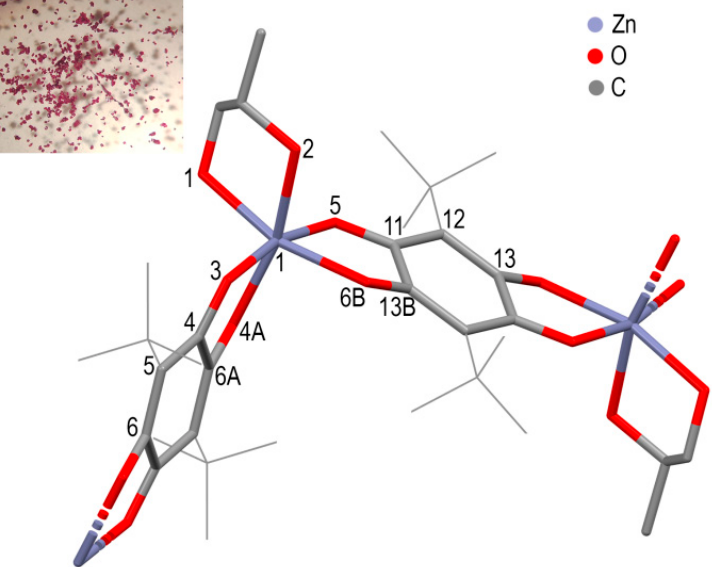
Figure 4. The view of molecular structure of the crystallographic unit in 2 . Photo of crystals is in the inset.